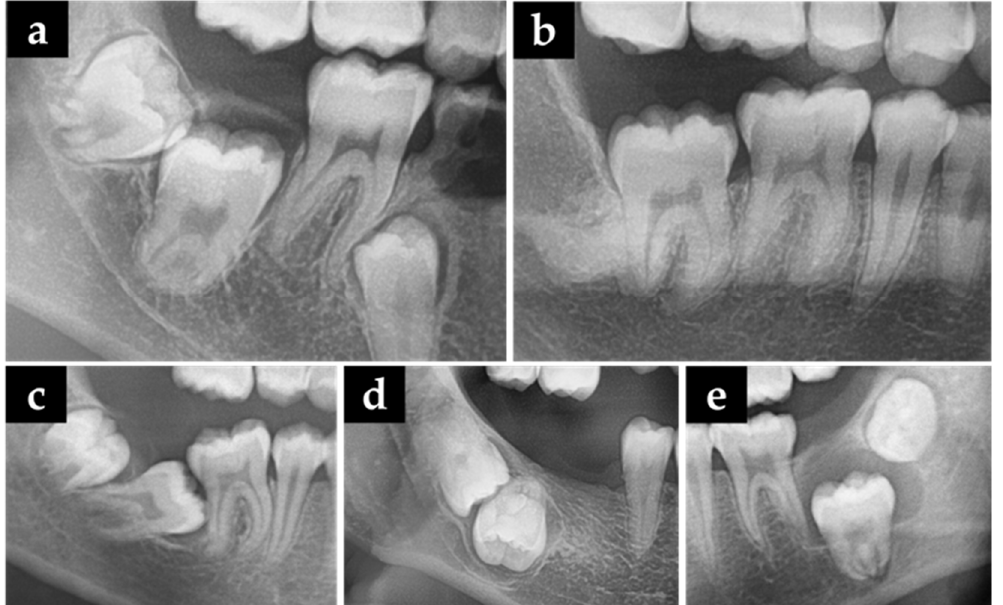
Figure 1. Panoramic radiographs revealed risk factors for eruption disturbances. ( a ) Primary reten- tion; ( b ) Secondary retention; ( c ) Impaction due to insufficient posterior space; ( d ) Impaction due to ectopic eruption path; ( e ) Impaction due to cyst of jaw.